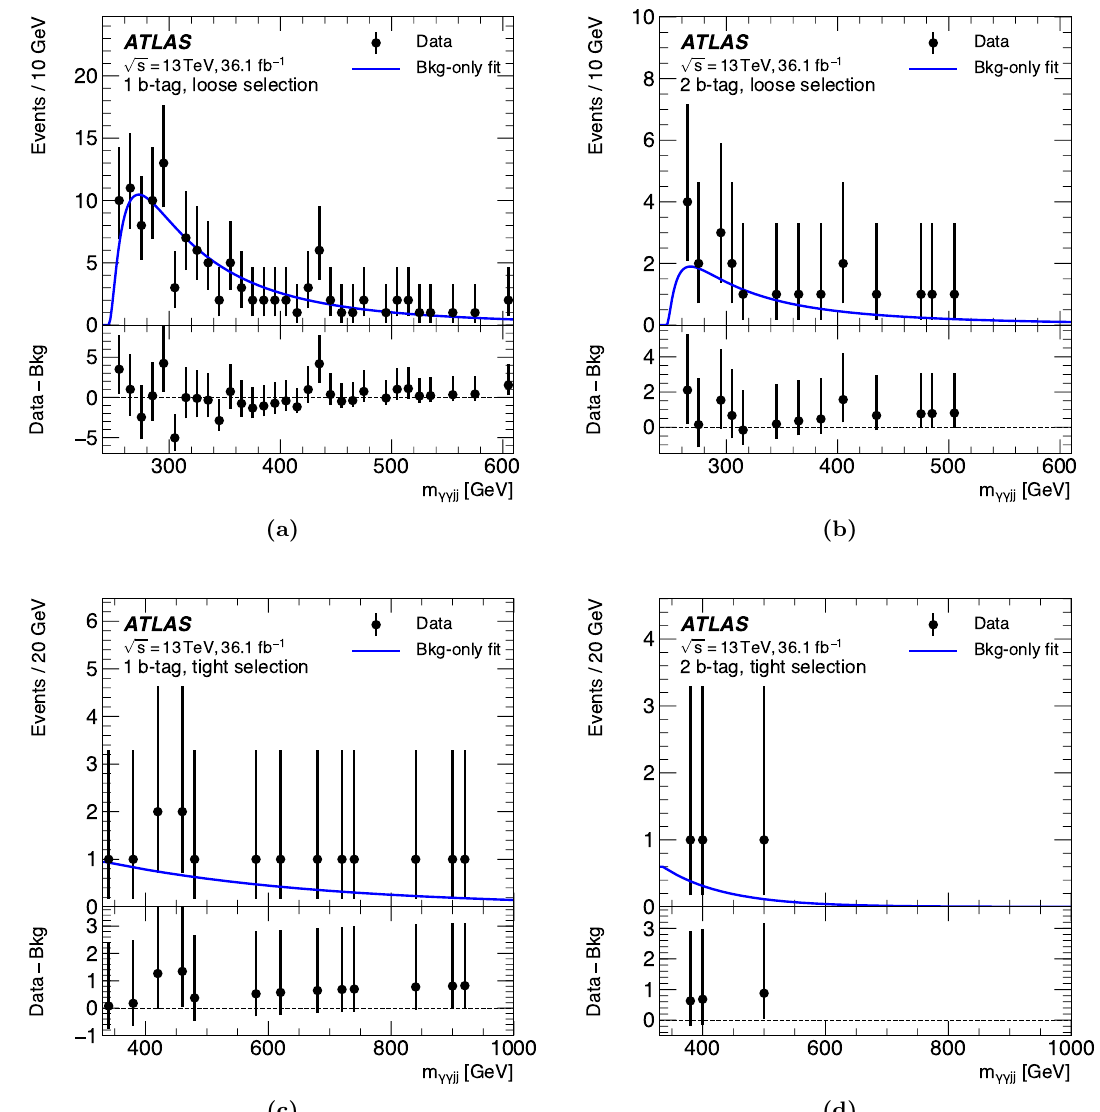
Figure 5. For the resonant analysis, data (black points) are compared with the background-only (cid:12)t (blue solid line) for m (cid:13)(cid:13)jj in the 1-tag (left) and 2-tag (right) categories with the loose (top) and tight (bottom) selections. The lower panel shows the residuals between the data and the best-(cid:12)t background.